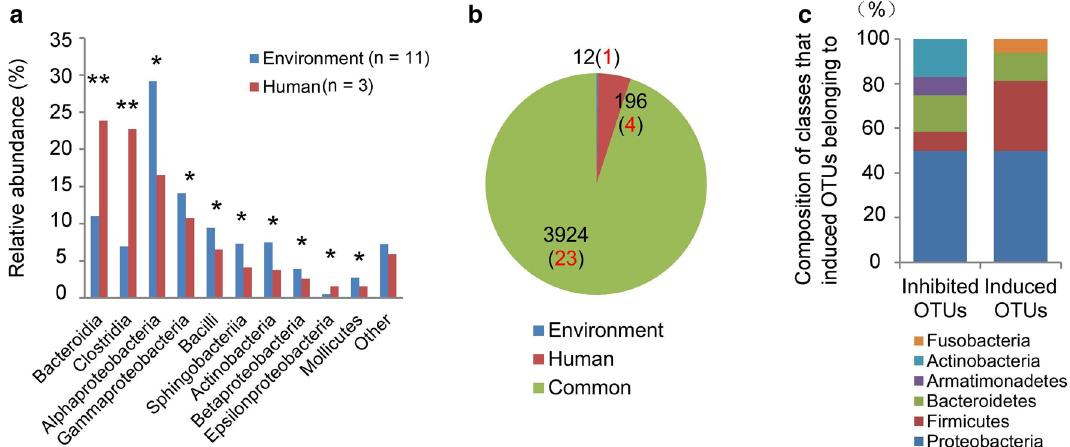
Figure 4. Behaviors of OTUs responding to different gaseous formaldehyde (CH 2 O) levels. The bacterial composition of environmental background and human oral cavity at the class level ( a ); the number of specific OTUs in the environmental background and human cavity ( b ); the proportion of classes that CH 2 O inhibited and induced OTUs belonging to ( c ). Numbers in red represent OTUs, which were significantly correlated with CH 2 O concentration. Mann–Whitney U test and Spearman’s analysis were performed. * P < 0.05, ** P < 0.01.